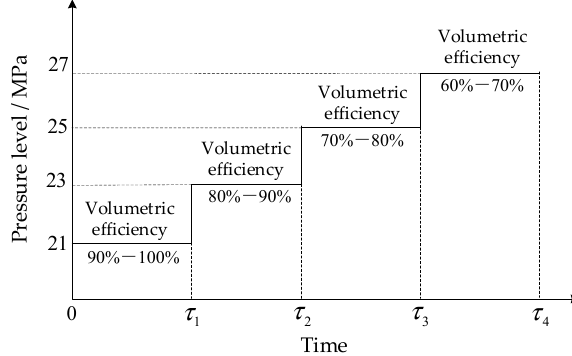
Figure 9. The schematic diagram of the step pressure acceleration test.